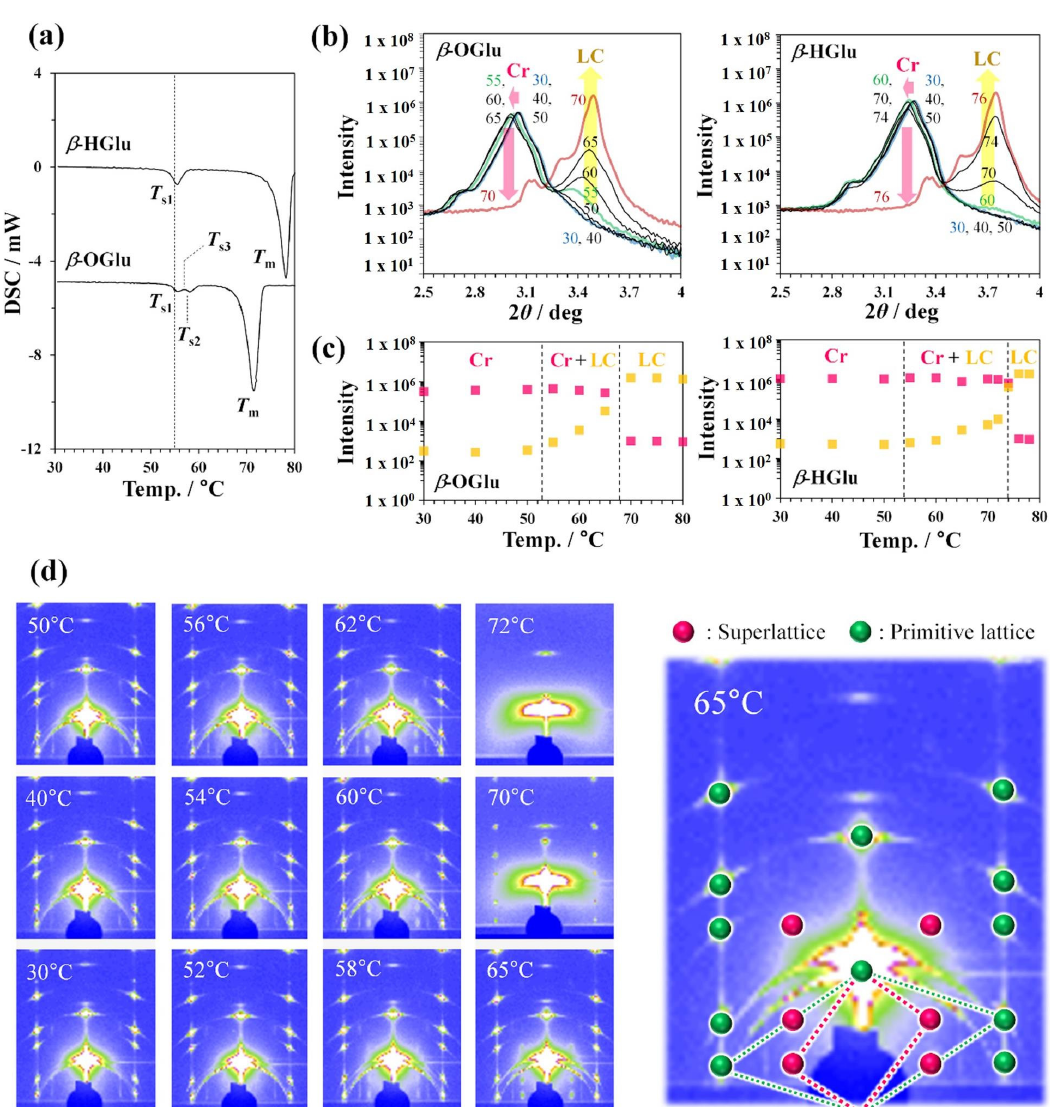
Figure 2. The solid-to-solid phase transitions. ( a ) DSC thermograms of β -OGlu and β -HGlu. The temperatures corresponding to the solid-to-solid phase transitions are termed T s in this article. In the thermogram for β -OGlu, two endothermic peaks ( T s1 and T s2 ) or one endothermic peak ( T s1 ) and one exothermic peak ( T s3 ) exist. ( b ) Temperature-dependent PXRD profiles at low diffraction angles and ( c ) the corresponding peak intensities. ( d ) 2D-GI-WAXD analysis of crystalline β -OGlu films. 2D-GI-WAXD profiles of (left) films under temperature-controlled conditions and (right) an extended profile obtained at 65 °C.